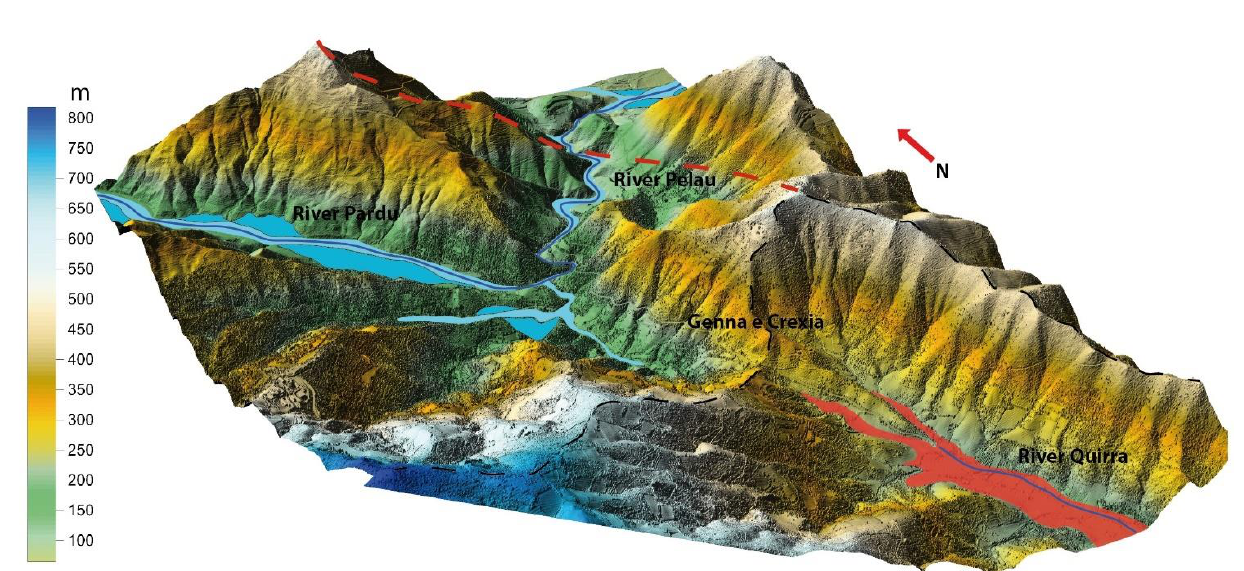
Figure 10. Three-dimensional LiDAR model of the river capture sector. In the north, the Pardu River flows eastwards, taking the name of Rio Pelau. The blue and light blue show the Holocene alluvial deposit of the Pardu River. South of Genna and Crexia is the head of the Rio Quirra. In red is shown the paleo-slope and paleo-alluvial deposits of the Quirra River. Table 3. Morphostratigraphic synthesis.